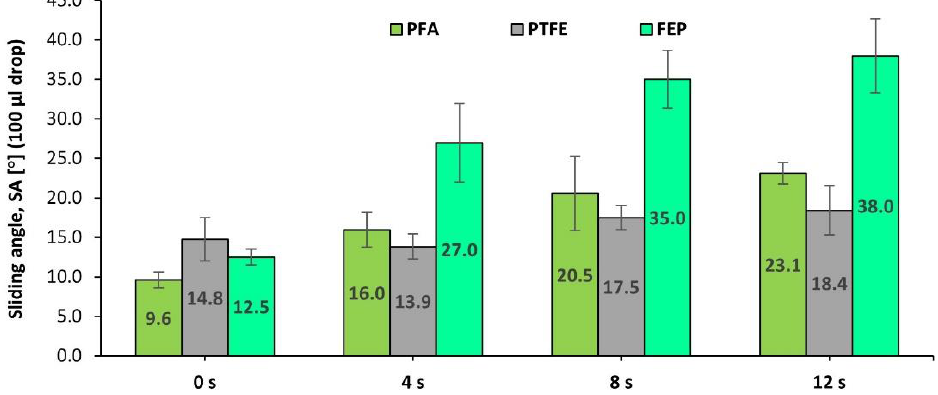
Figure 10. Evolution of the sliding angle (SA) of PFA-, PTFE-, and FEP-based fluoropolymeric coatings after 0, 4, 8, and 12 s wear processes via the projection of glass microspheres at 0.4 MPa.